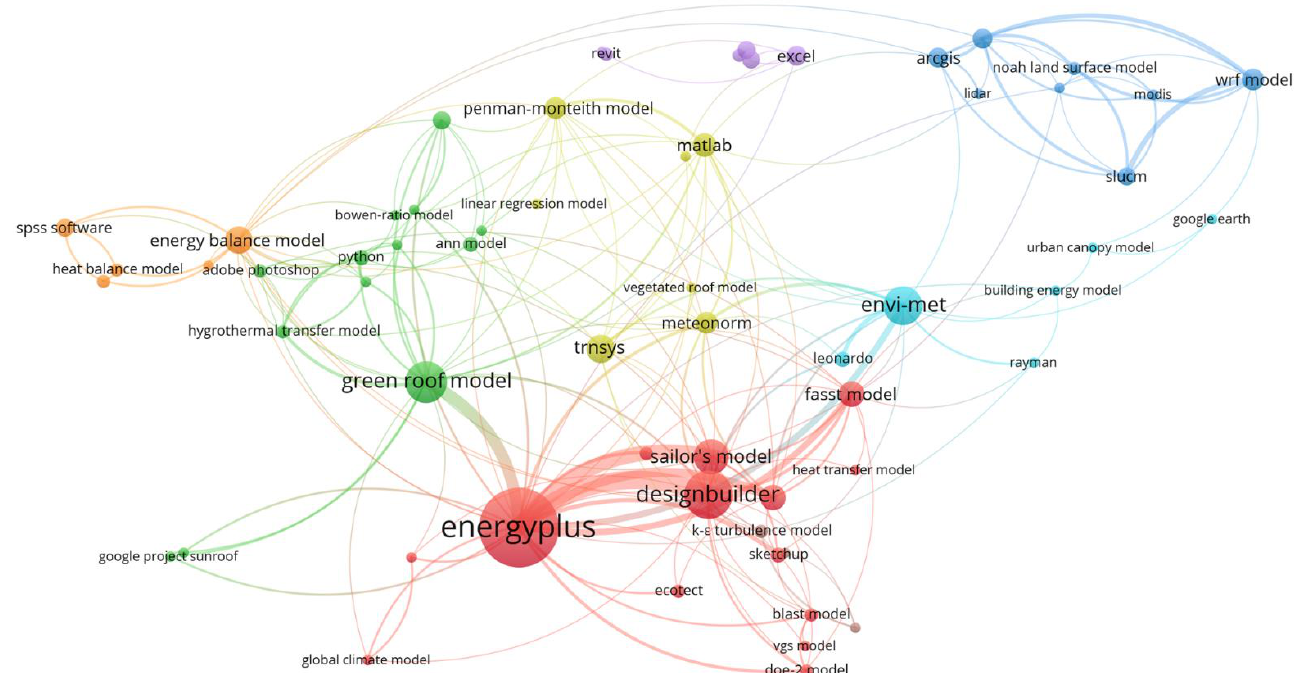
Figure 16. The connections and relationships among methods and tools. This figure was produced using a VOS viewer based on the occurrence of the tools and methods keywords. The thickness of the line represents stronger or weaker links between the keywords.